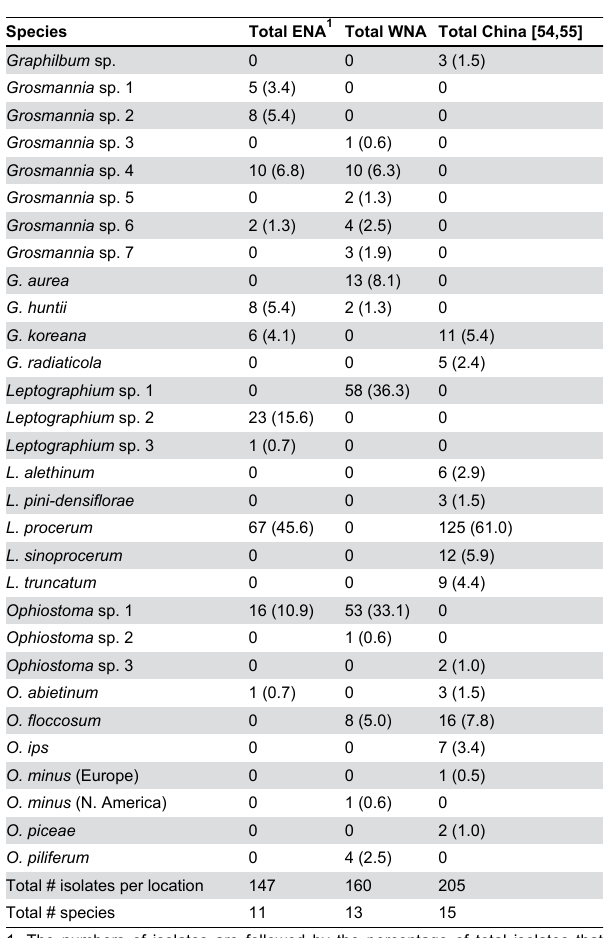
Table 1. Numbers of isolates of each Ophiostomatalean species collected in ENA, WNA, and China.